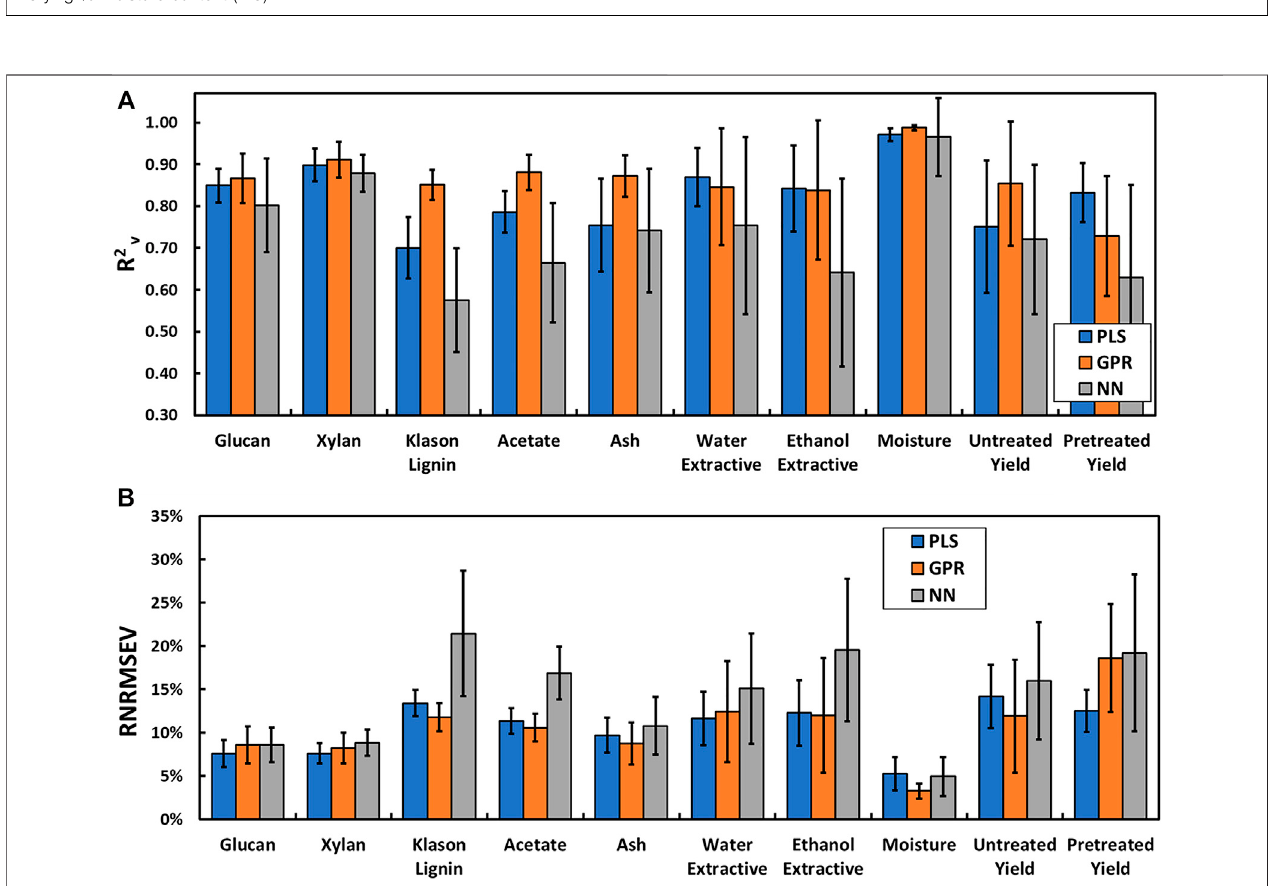
FIGURE6| R 2 v (A) andRNRMSEV (B) forchemicalcompositionandresponsetopretreatmentandenzymatichydrolysisofcornstoverpredictedfromNIRspectra using partial least squares (PLS), Gaussian process regression (GPR) and neural networks (NN). Bars represent standard deviations over 100 model runs. Tabular data are provided in the Supplementary Material